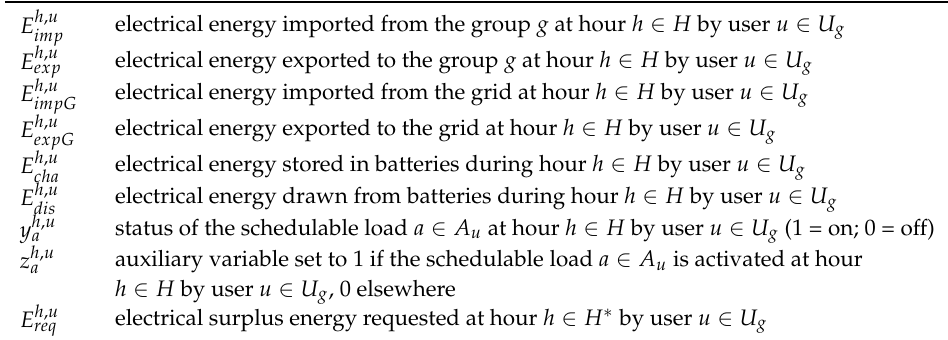
Table 2. Variables of the optimization model.